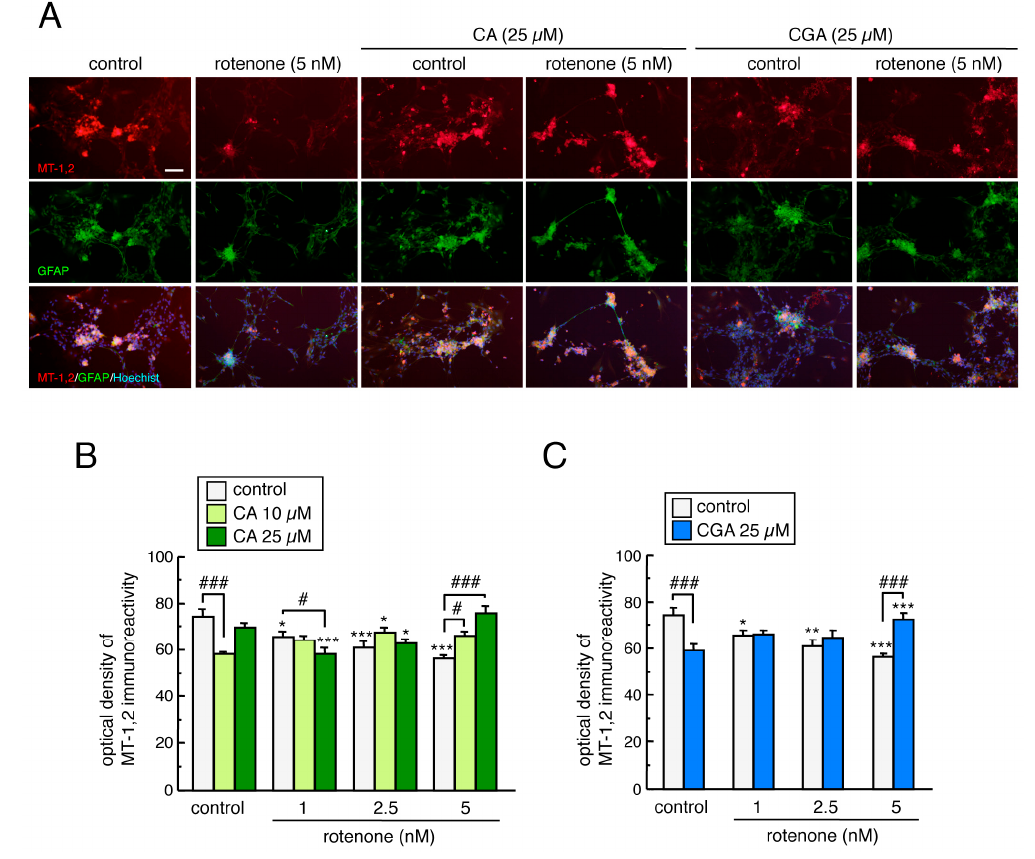
Figure 8. Treatment with CA or CGA inhibits rotenone-induced MT downregulation in the enteric glial cells. Enteric neuronal and glial co-cultures were pretreated with CA (10 or 25 µ M) or CGA (25 µ M) for 24 h and co-treated with rotenone (1–5 nM) for a further 48 h. ( A ) Representative photomicrographs of immunohistochemistry for MT-1,2 and GFAP in enteric cell cultures after treatment with rotenone (5 nM) and CA (25 µ M) or CGA (25 µ M). Red: MT-1,2-positive signals. Green: GFAP-positive enteric glial cells. Blue: nuclear staining with Hoechst 33342. Scale bar = 100 µ m. ( B , C ) Quantitation of MT-1,2-positive signals in the enteric cell cultures after treatment with rotenone and CA ( B ) or CGA ( C ). Data are means ± SEM (n = 3–8). * p < 0.05, ** p < 0.01, *** p < 0.001 vs. each control group; # p < 0.05, ### p < 0.001 between the two indicated groups.